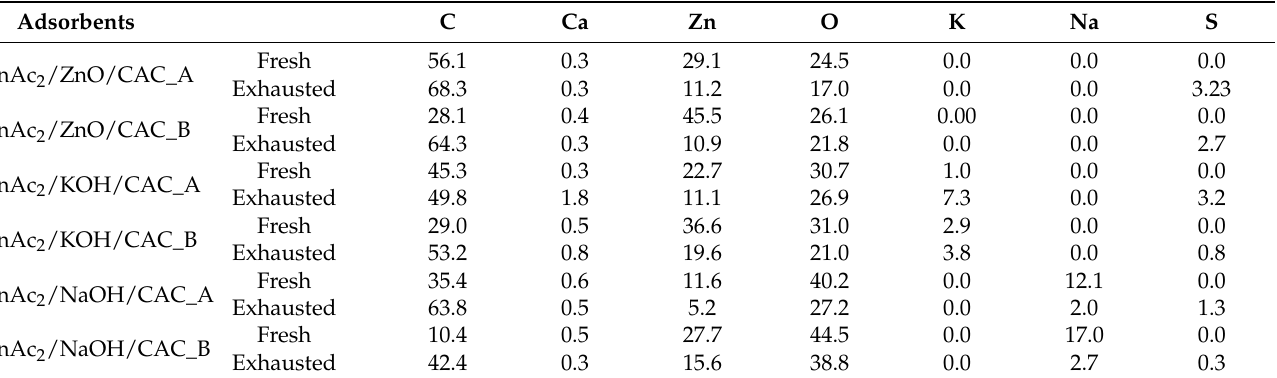
Table 1. Contents of elements in fresh and exhausted